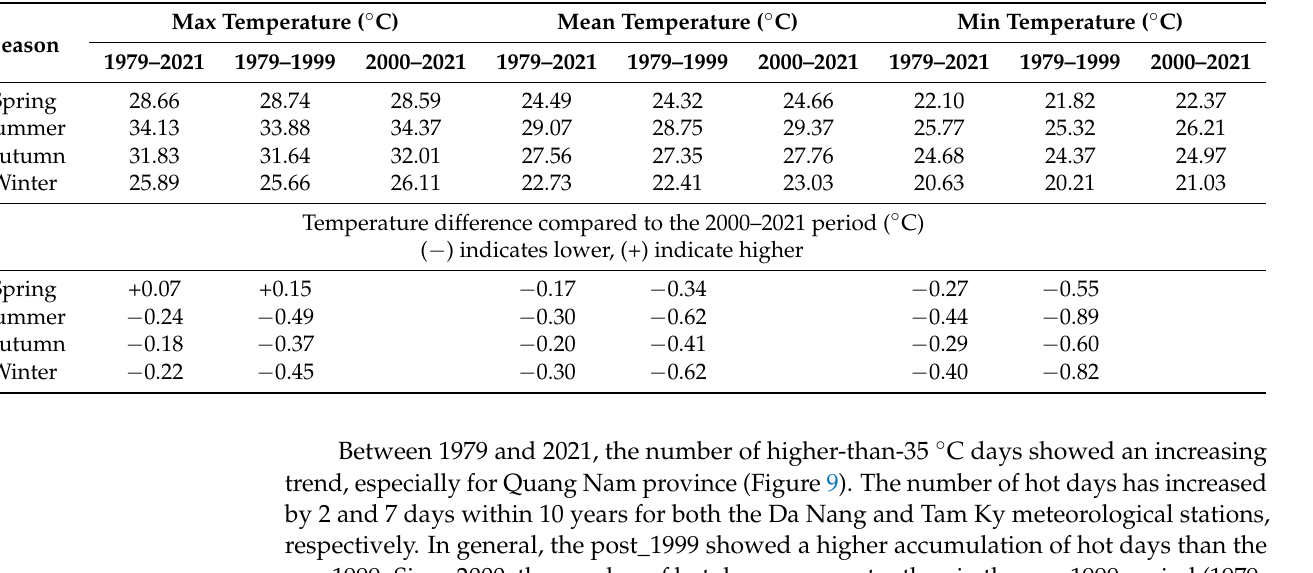
Table 6. The maximum, minimum, and mean temperatures in different study periods for the Da Nang meteorological